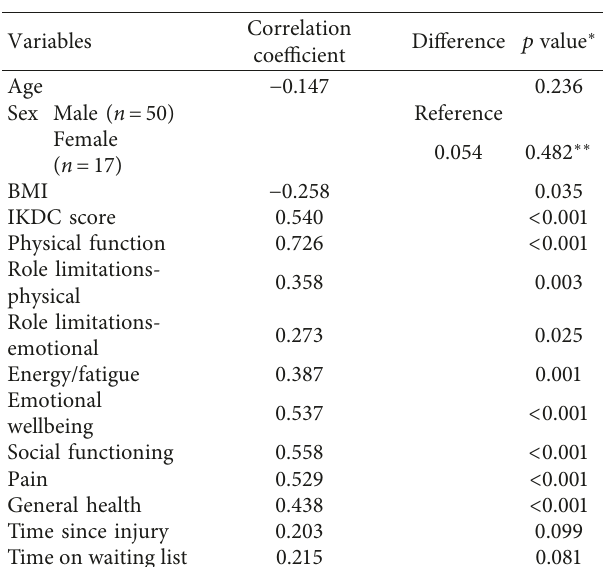
Table 2: Patient variables associated with EQ-5D 5L score on unadjusted analysis for those awaiting ACL reconstruction.